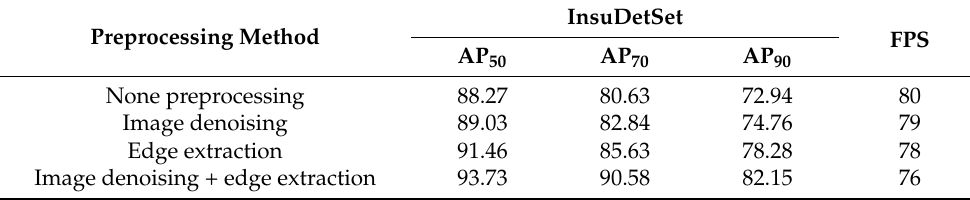
Table 6. APs of different preprocessing